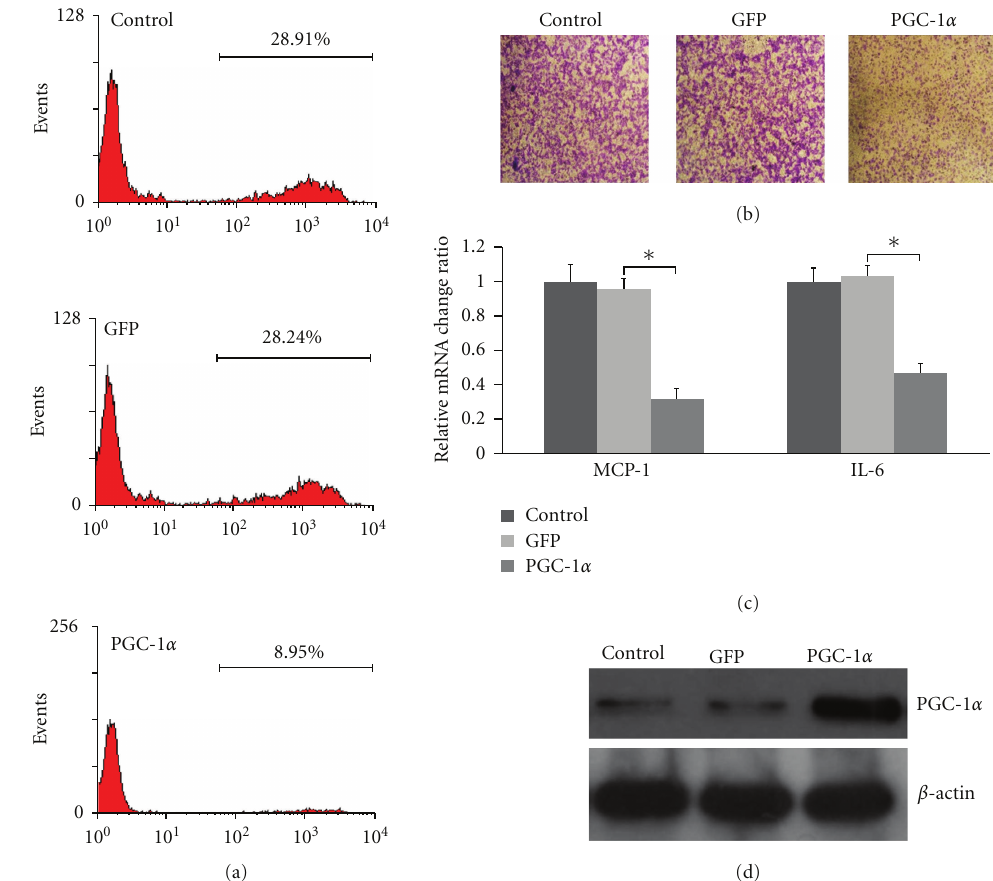
Figure 2: Overexpression of PGC-1 α inhibited proliferation, migration, and inflammatory gene expression of VSMCs in high glucose. VSMCs cultured in high-glucose (25mmol/L) complete media were deprived of serum for 24 h. The cells were then treated with adenovirus infection for 48h. (a) Proliferation of VSMCs, (b) migration of VSMCs, (c) inflammatory gene expression of VSMCs ( ∗ P < 0 . 05), and (d) Western blotting analysis for PGC-1 α in